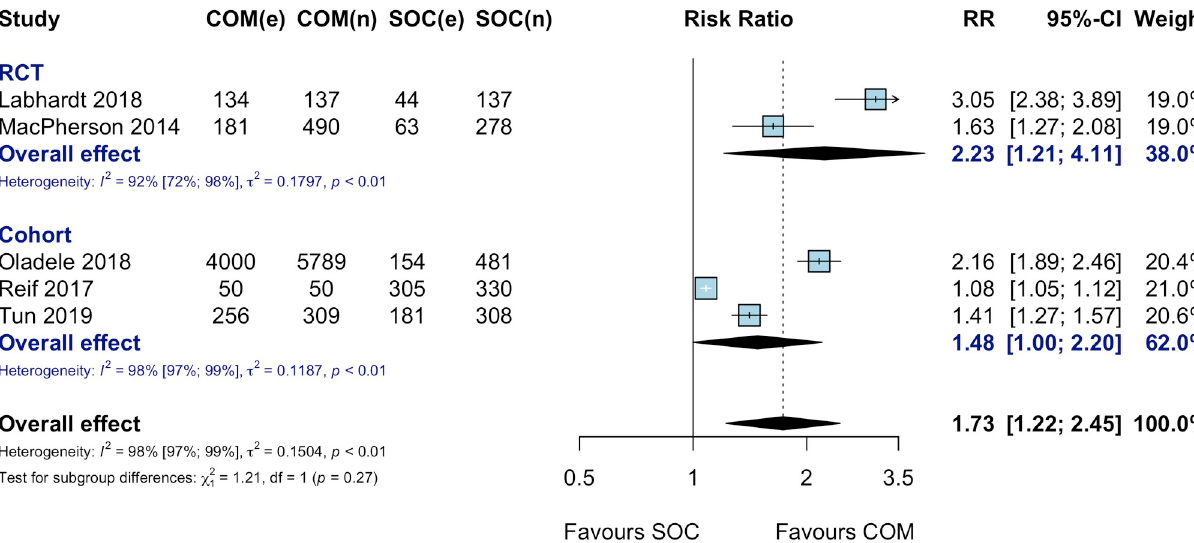
Fig 3. ART uptake: Community ART initiation versus standard of care among HIV-positive individuals, by study design. COM, community ART initiation; e, number of events; n, number of participants; RCT, randomized controlled trial; RR, risk ratio; SOC, standard of care. MacPherson 2014 cluster-adjusted effect estimate based on the Cochrane method of adjusting for the design